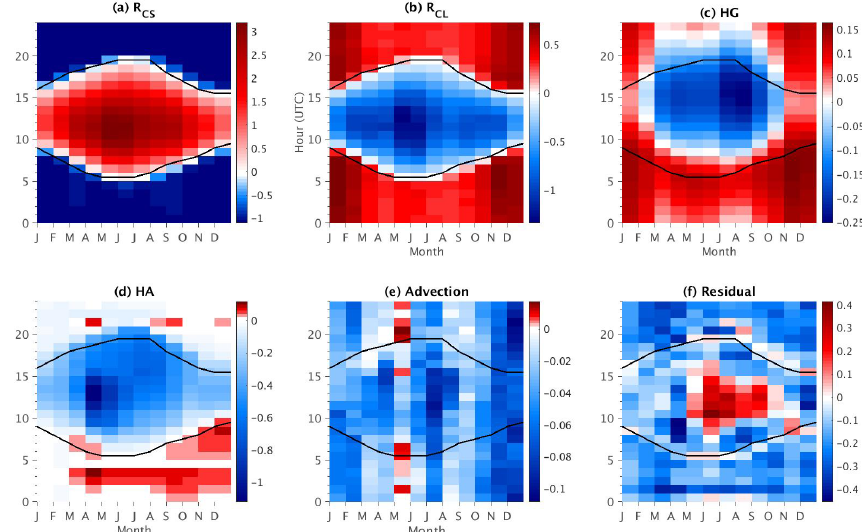
Figure 4. Monthly–hourly mean values for (a) R CS , (b) R CL , (c) HG, (d) HA, (e) Adv, and (f) the residual (i.e., difference between the model and the observations). Units on the color bars are all in ◦ Ch − 1 , and their scale is different for each subfigure. The black contour line on each figure corresponds to sunrise (bottom line) and sunset (top line) approximate